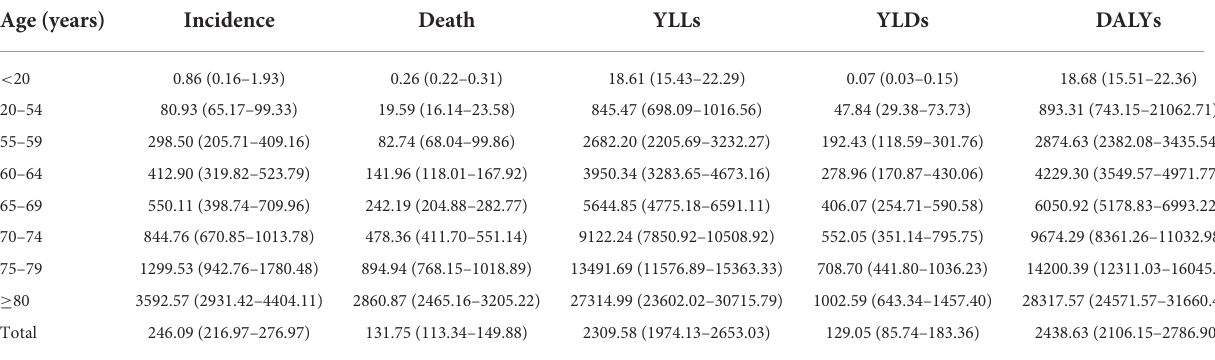
TABLE 1 Disease burden of IHD in various age-groups in China, in 2019